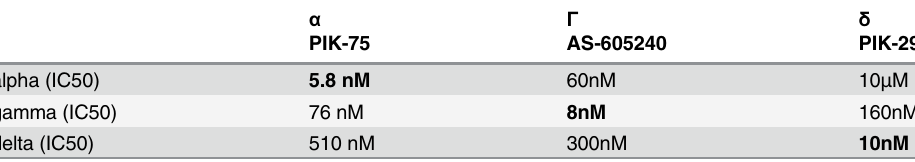
Table 2. IC50s of the PI3 kinase isoform